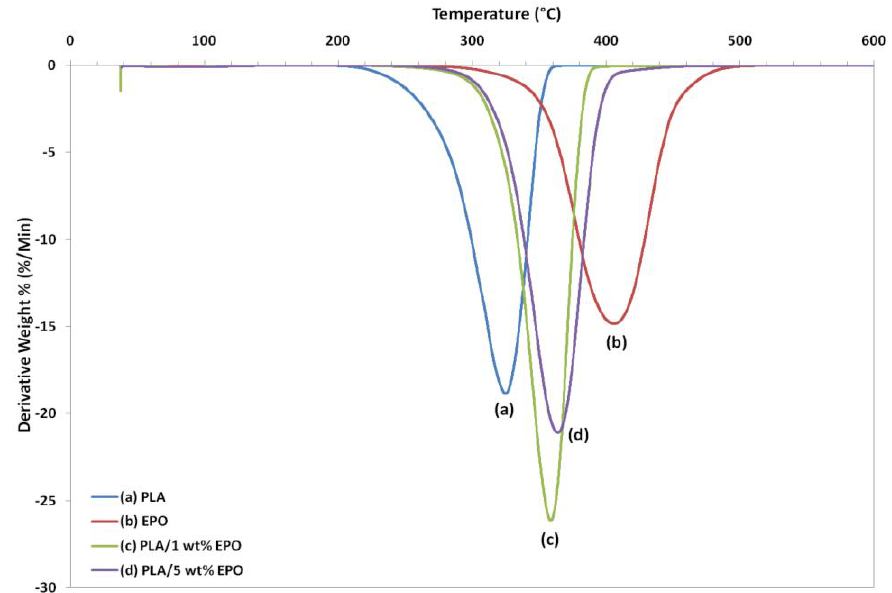
Figure 12. DTG thermograms of neat PLA and PLA/EPO